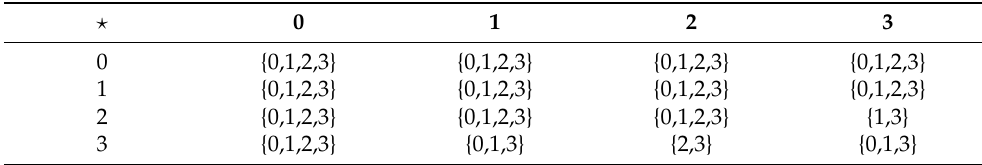
Table 4. The binary hyperoperation (cid:63) on C .